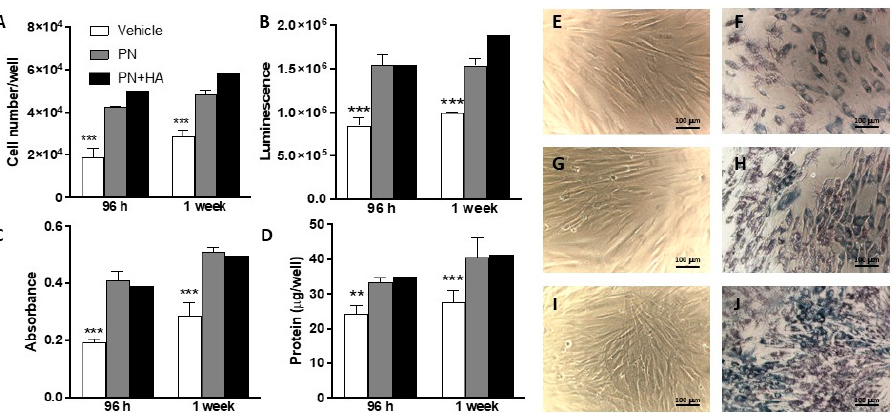
Figure 1. ( A ) A Coulter Counter was used to determine cell number at 96 h and 1 week of culture. PN and PN + HA significantly increased cell number (*** = p < 0.001 control vs. either stimulated group). ( B ) Cell Titer GLO assay was used to assay cell viability in the control, PN or PN + HA groups at 96 h and 1 week of culture. PN or PN + HA significantly increased viability vs. the control at both time-points. (*** = p < 0.001 control vs. PN and PN + HA). ( C ) MTT viability assay was carried out at 96 h and 1 week of culture. PN, with or without HA, significantly increased cell viability at 96 h and 1 week of culture. *** = p < 0.01 control vs. PN or PN + HA groups. ( D ) Lowry assay was also used to determine the protein control, PN or PN + HA groups after 96 h and 1 week of culture. Protein levels were significantly higher in the presence of PN or PN + HA at 96 h and 1 week of culture. ** = p = 0.0068 control vs. PN, p = 0.0023 control vs. PN + HA; *** = p = 0.0006 and p = 0003 control vs. PN and PN + HA, respectively. ( E , G , I ) Microphotographs of primary human fibroblasts at 1 week of culture in the control group ( E ) or in PN ( G ) or PN + HA ( I ) groups, at phase contrast microscopy. Magnification = 10× (Bar = 100 μ m). ( F , H , J ) Microphotographs of primary human fibroblasts at 1 week of culture in control group ( F ) or in PN ( H ) or PN + HA ( J ) groups, after adding MTT, which generates blue needle-shape precipitates upon reduction to Formazan. Cells appeared more numerous in the presence of PN ( G , H ), but even more so with the addition of HA, where cells appear stacked in multi-layered nodules ( I , J ).